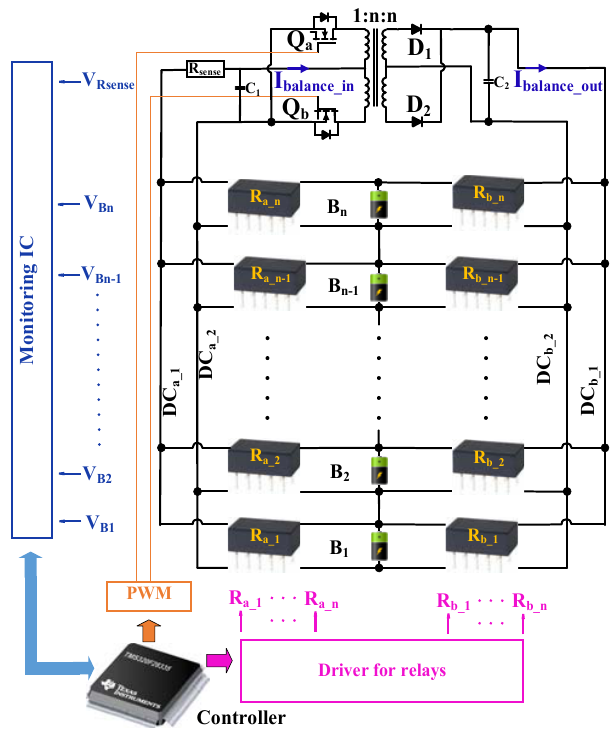
Figure 1. Structure of the proposed cell ‐ to ‐ cell balancing circuit.